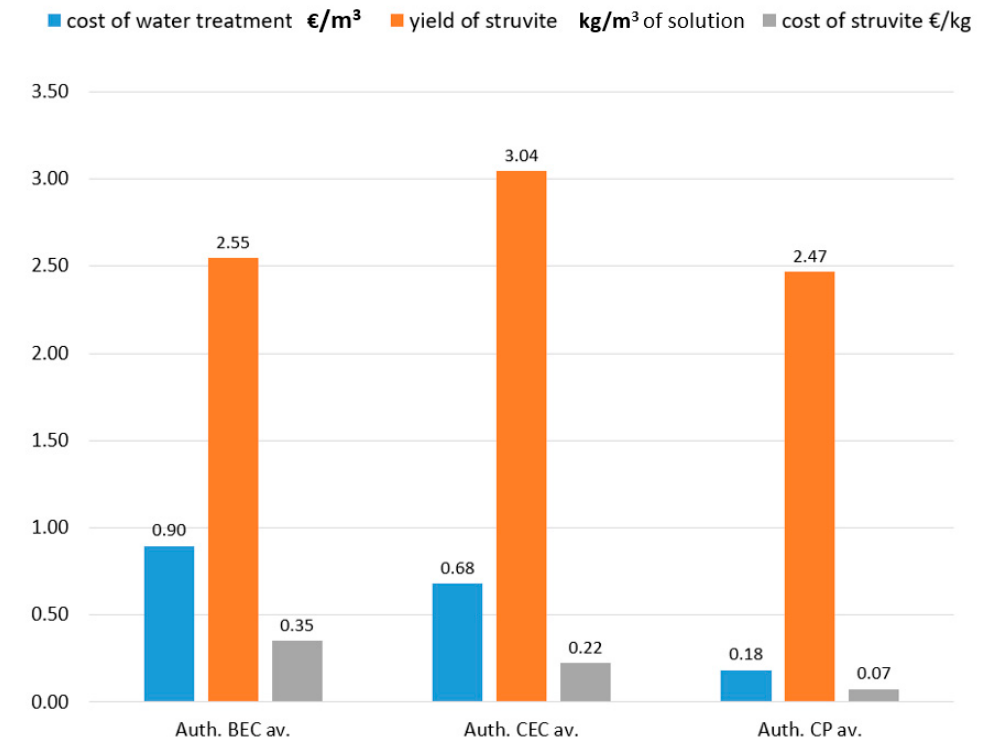
Figure 8. Average operational cost, struvite yield, and cost of 1 kg of struvite in the AWT. BEC av., batch electrocoagulation average value, CEC av., continuous electrocoagulation average value; and CP av., chemical precipitation average